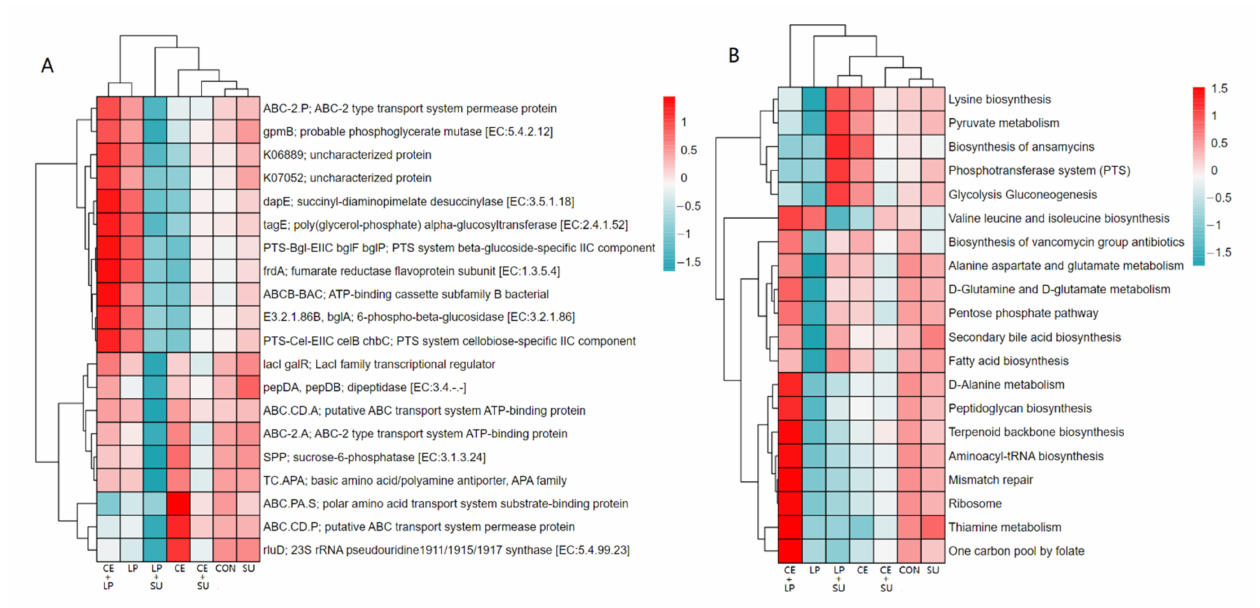
Figure 3. Heatmap of the top 20 predicted functions ( A ) and pathways ( B ) of the bacterial commu- nities analyzed via PICRUSt2 for hybrid Pennisetum silage (CON, control group; CE, 100 U/g FM cellulase addition; LP, 1 × 10 6 cfu/g FM Lactobacillus plantarum addition; SU, 1% FM sucrose